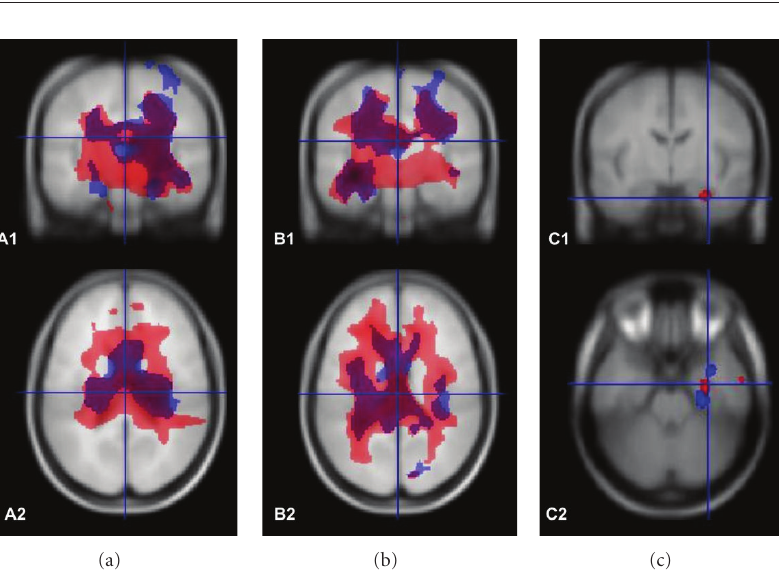
Figure 1: Right side represents left side of the head. (a) A1 and A2: left MTLE; these images show the pattern of atrophy in coronal and axial slices, respectively, in a superposition of T1 and T2 acquisitions. The area colored in red represents areas of WM atrophy in T1-weighted images, and the area in blue represents WM atrophy in T2-weighted images. The intersection T1 and T2 is shown in purple. The figures show a bilateral pattern of WM atrophy, detected by both acquisitions, and a more widespread area in T1-weighted images, despite a considerable area of superposition. (b) B1 and B2: right MTLE; these images show the pattern of atrophy in coronal and axial slices, respectively, in a superposition of T1 and T2 acquisitions. The area colored in red represents WM atrophy in T1-weighted images, and the area in blue represents WM atrophy in T2-weighted images. The intersection T1 and T2 is shown in purple. The figures show a bilateral pattern of WM atrophy, detected by both acquisitions, and a more widespread area of WM atrophy in T1-weighted images, despite of a considerable area of superposition. (c) C1 and C2: left minus right MTLE groups: we made a subtraction between left and right MTLE patients. This subtraction evidentiates a pronounced WM atrophy in the ipsilateral (left) mesial